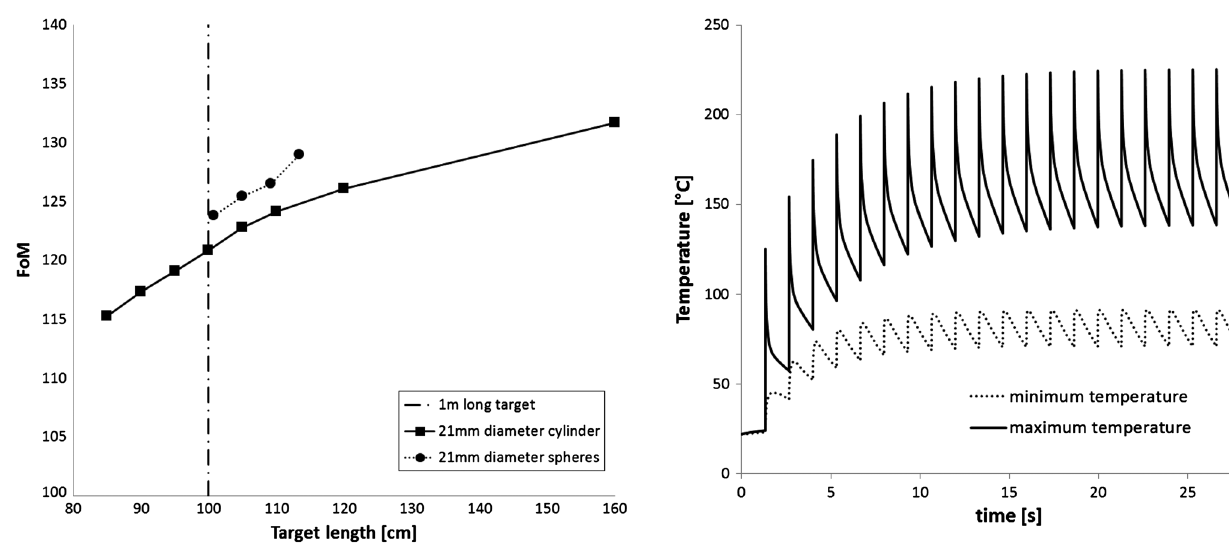
FIG. 8. FOM in spheres and cylinders as a function of target length.